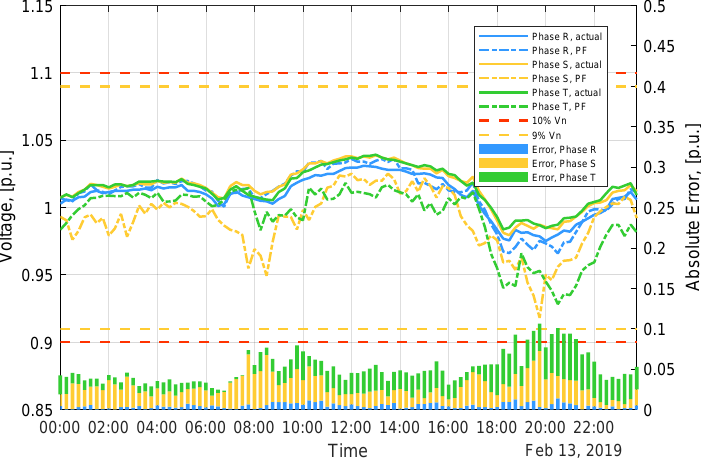
Figure 6. Model validation. Total active power consumption for the four representative days.